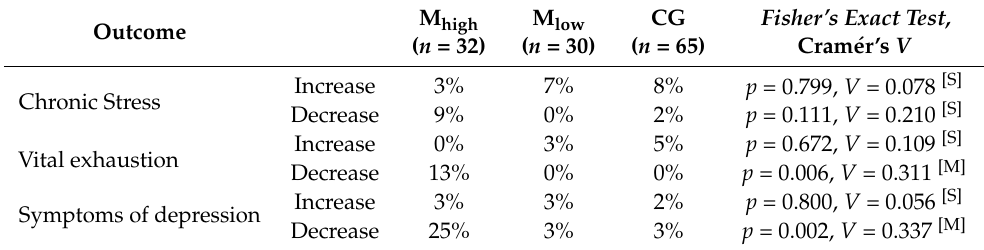
Table 5. Reliable change